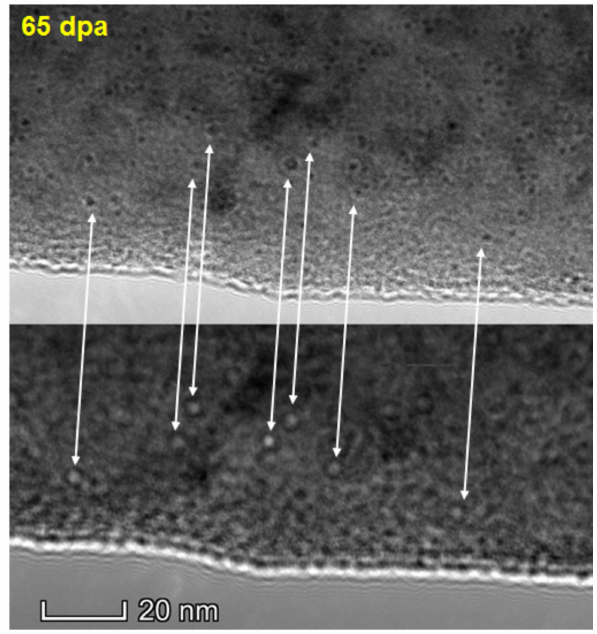
Figure 17. Pair of over- and under-focused BF TEM images in 65 dpa FTT material, confirming the presence of fine cavities induced by neutron irradiation.